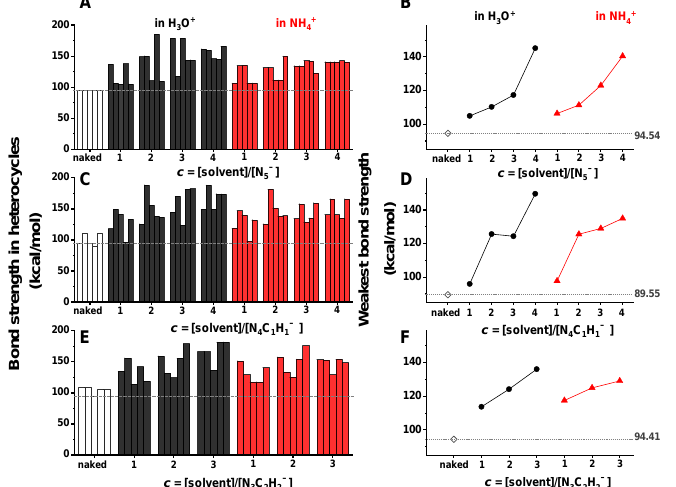
Figure 5. All bond strengths and weakest bond strengths in the rings of ( A , B ) N 5 ¯, ( C , D ) N 4 C 1 H 1 ¯, and ( E , F ) N 3 C 2 H 2 ¯ in variant H 3 O + /NH 4+ concentration. The weakest bond strength in the ring of each naked heterocyclic anion is marked by a dashed line for comparison.